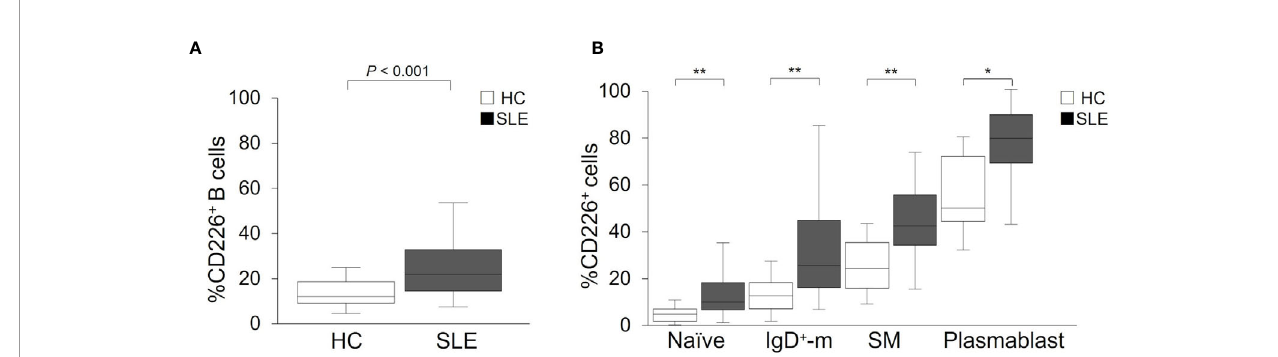
FIGURE 1 | CD226 expression on B cell subsets in SLE patients and healthy controls (HCs). Proportions of CD226 + cells in B cells (A) , naive B cells, IgD + -memory (IgD + -m) B cells, switched-memory (SM) B cells, and plasmablasts (B) were compared between SLE patients and HCs. The median (interquartile range) proportions of CD226 + cells from SLE patients and HCs were 21.9% (14.4 – 32.9) and 11.9% (9.0 – 18.5) in B cells; 10.6% (7.4 – 18.7) and 5.4% (2.4 – 7.5) in naive B cells; 25.9% (16.6 – 44.9) and 13.2% (7.6 – 18.8) in IgD + -m B cells; 42.6% (34.5 – 55.5) and 24.8% (16.4 – 35.6) in SM B cells; 79.3% (69.0 – 89.3) and 50.0% (44.6 – 71.8) in plasmablasts. Box plots represent the median values, interquartile ranges, and the range of values. Statistical differences among groups were evaluated using the Mann – Whitney U test (* P < 0.005, ** P <